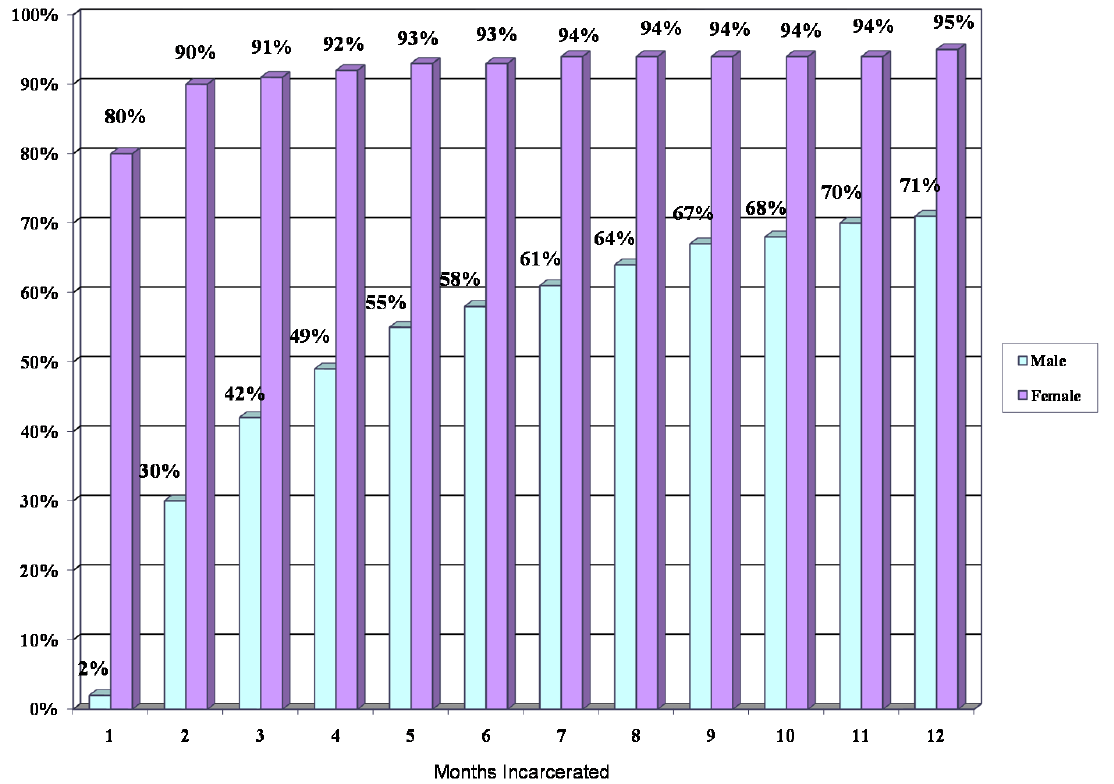
Figure 3. Cumulative Attendance for Male (N = 3009) and Female (N = 349) Across Months of